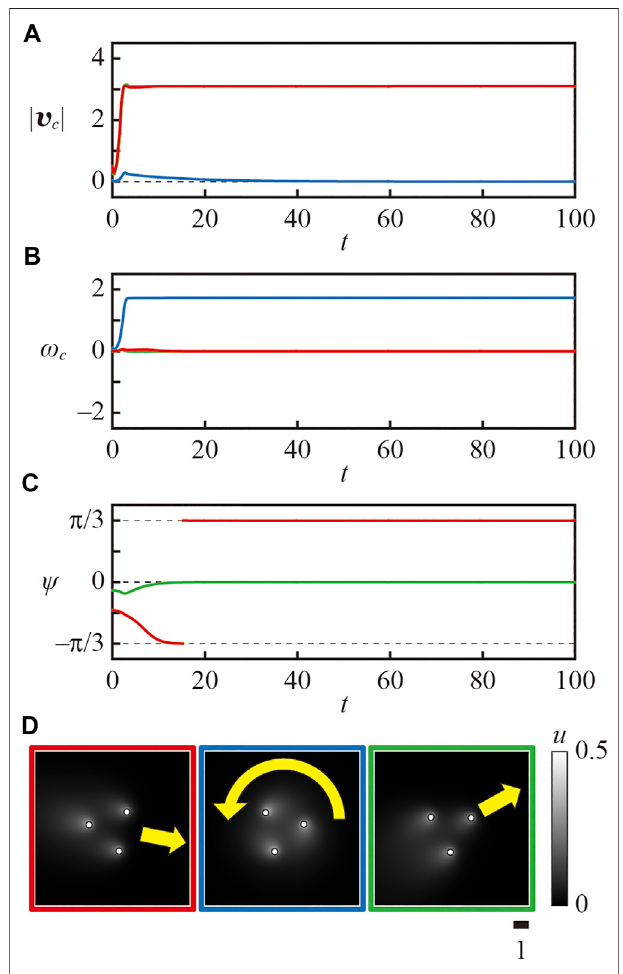
FIGURE 7 | Numerical results on the time series of (A) velocity | v c | , (B) angular velocity ω c , and (C) angle difference between the velocity and characteristic angle θ c for the camphor fl oat with n = 3. κ was fi xed to 0.08 and ℓ was fi xedto1.5.Theresultsfromvariousinitialconditionswererepresented in different colors. Angle difference was plotted only for the case that | v c | was convergedtoanon-zerovalue.Itshouldbenotedthat ψ hasaperiodicityof2 π /3. (D) Snapshots at t = 100 from each initial condition indicated in the same color. The initial conditions were (red) v c = 0.5 e x + 0.01 e y , ω c = 0.01, and (blue) v c = 0.02